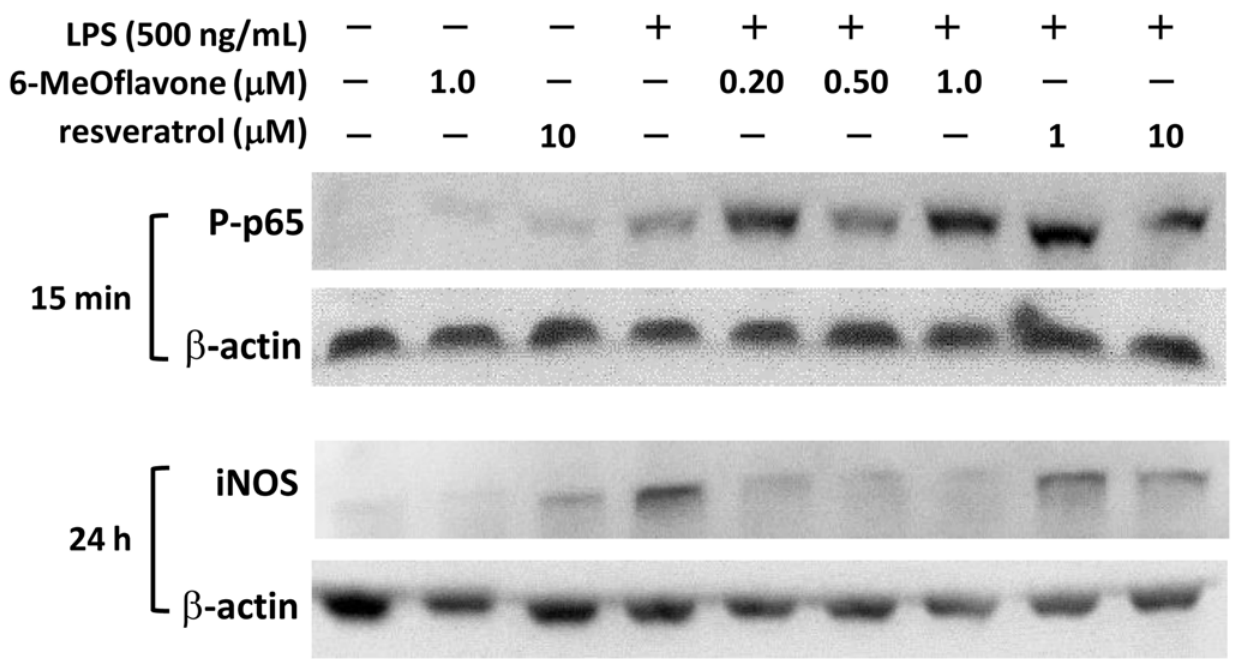
Fig 5. Western blot analysis of potential molecular targets by 6-methoxyflavone in kidney mesangial cells with LPS as the inflammatory stimuli. Cells were pretreated with 6-methoxyflavone or resveratrol for 12 h and then LPS was added. Cell lysate were collected after 15 min and 24 h incubation for activated NF- κ B pathway and iNOS protein,